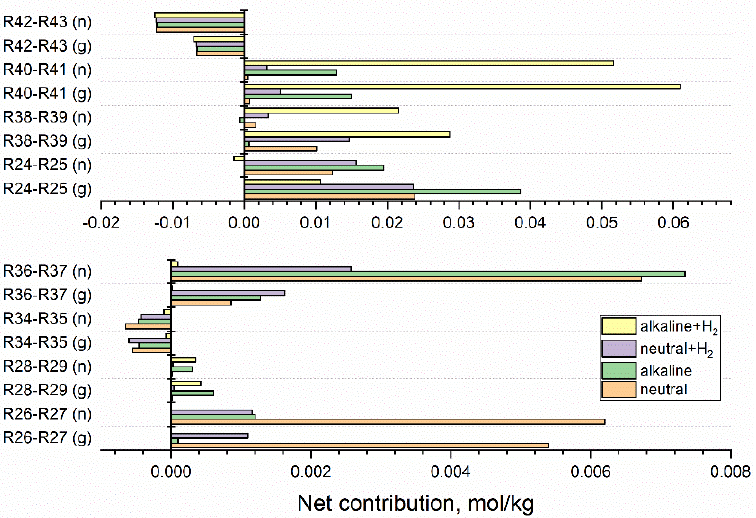
Figure 6. Net contributions of equilibria reactions calculated for 1 kGy · s − 1 fast neutron (n) and gamma (g) radiolysis of neutral water, alkaline solution, and hydrogenated (3 · 10 − 5 mol · kg − 1 H 2 ) neutral and alkaline systems. Equilibria resulting in net contribution below 1 · 10 − 4 mol · kg − 1 are not shown.